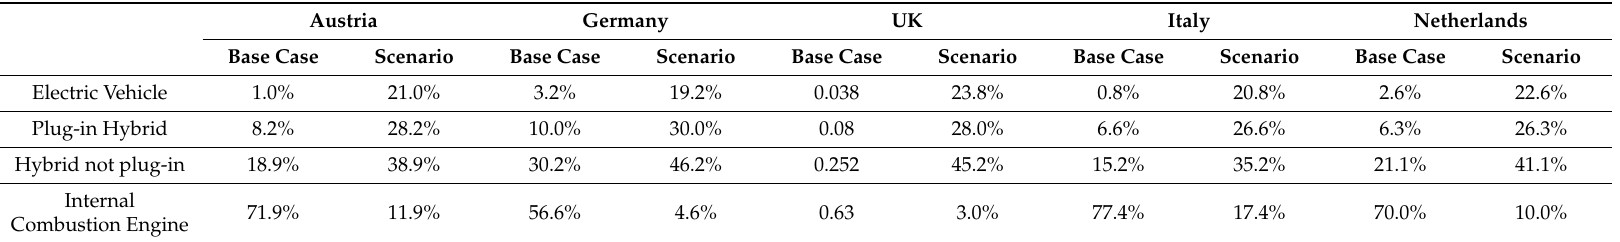
Table 4. Shares of fuels and electricity in public passenger and freight transport in 2030.